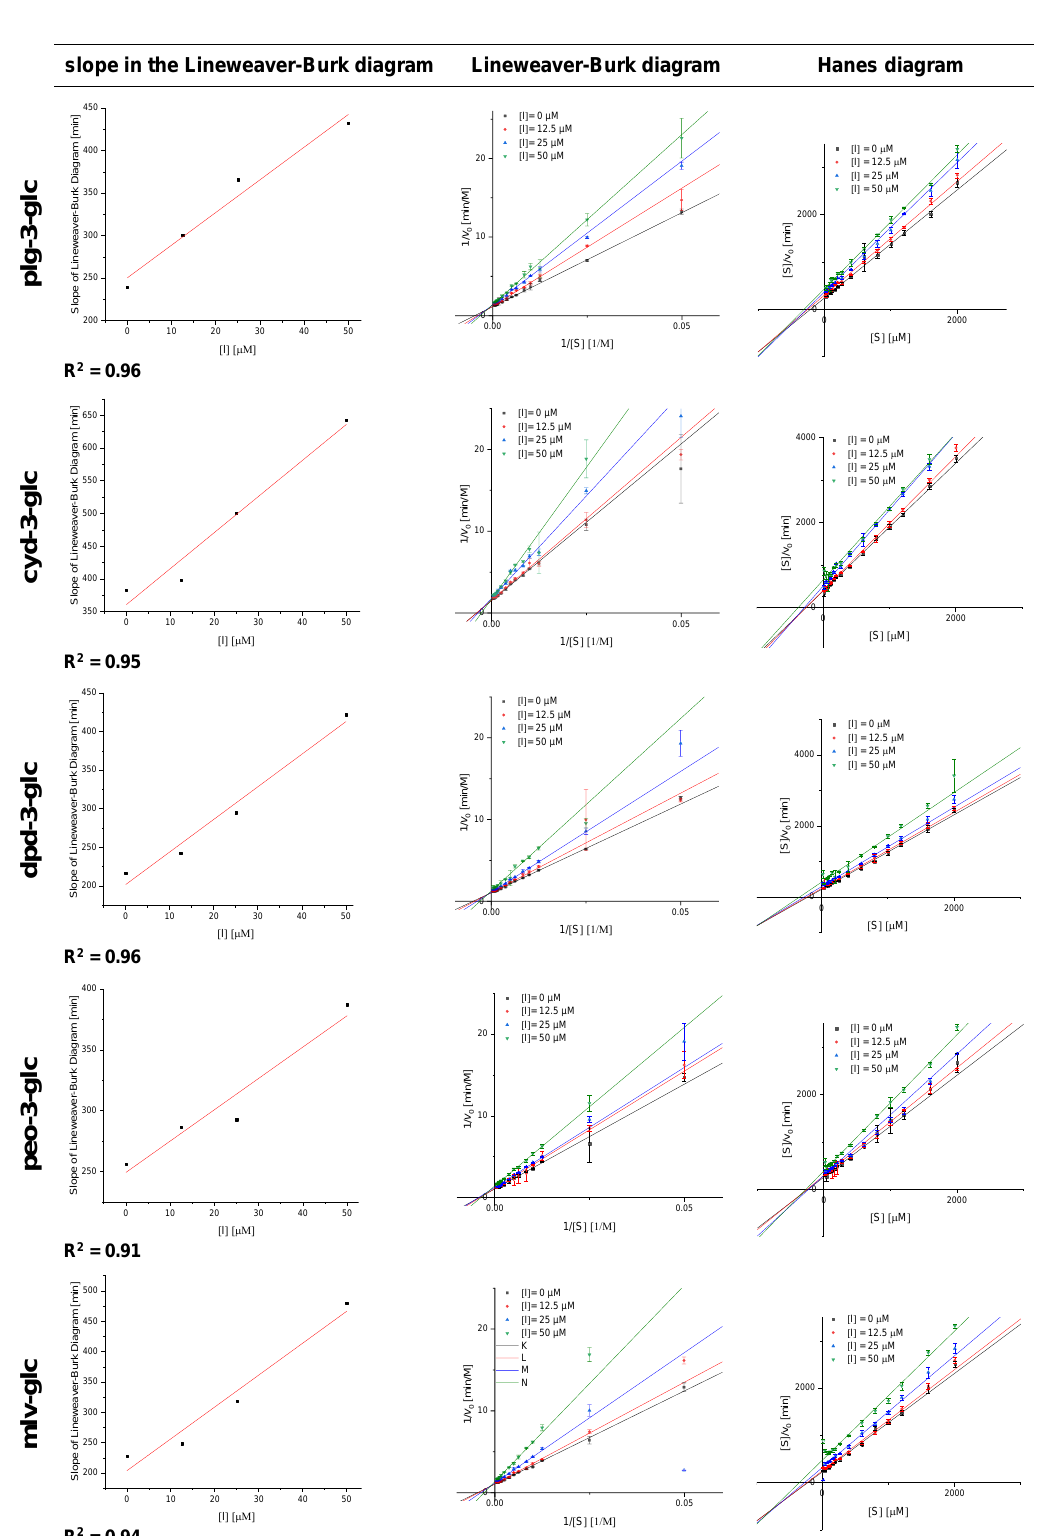
Figure A2. Linearized plots to demonstrate complete inhibition and to evaluate inhibition type. Abbr.: Plg-3-glc, pelargonidin-3-glucoside; Cyd-3-glc, cyanidin-3-glucoside; Dpd-3-glc, delphinidin-3-glucoside; Peo-3-glc, peonidin-3-glucoside; Mlv-3-glc, malvidin-3-glucoside; [I], inhibitor concentration; [S],substrate concentration; v 0 , measured conversion rate at used substrate and inhibitor